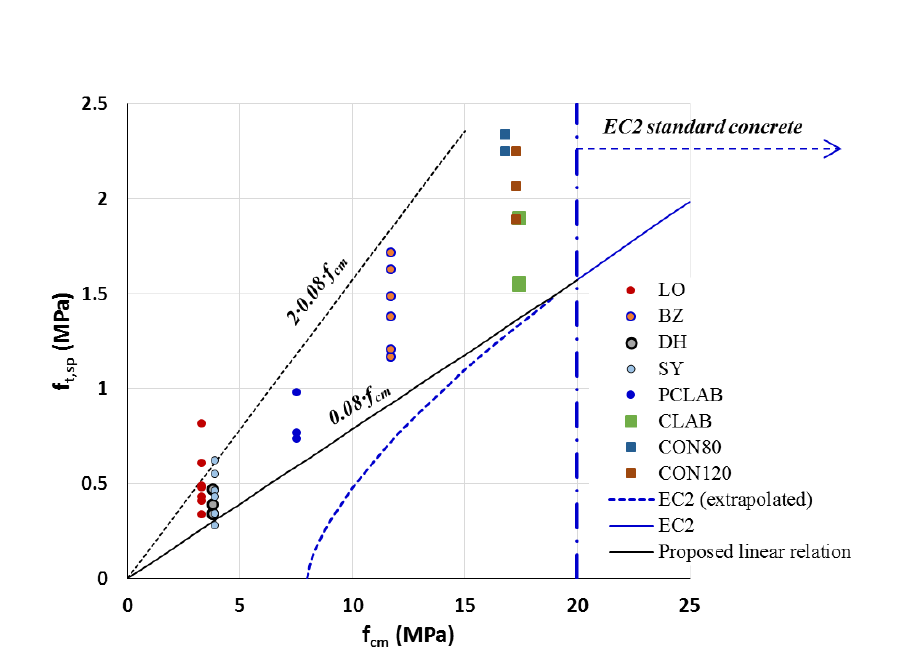
Figure 6. Relationship between axial tensile strength and the mean compressive strength, Reprinted with permission from [14], Copyright 2021